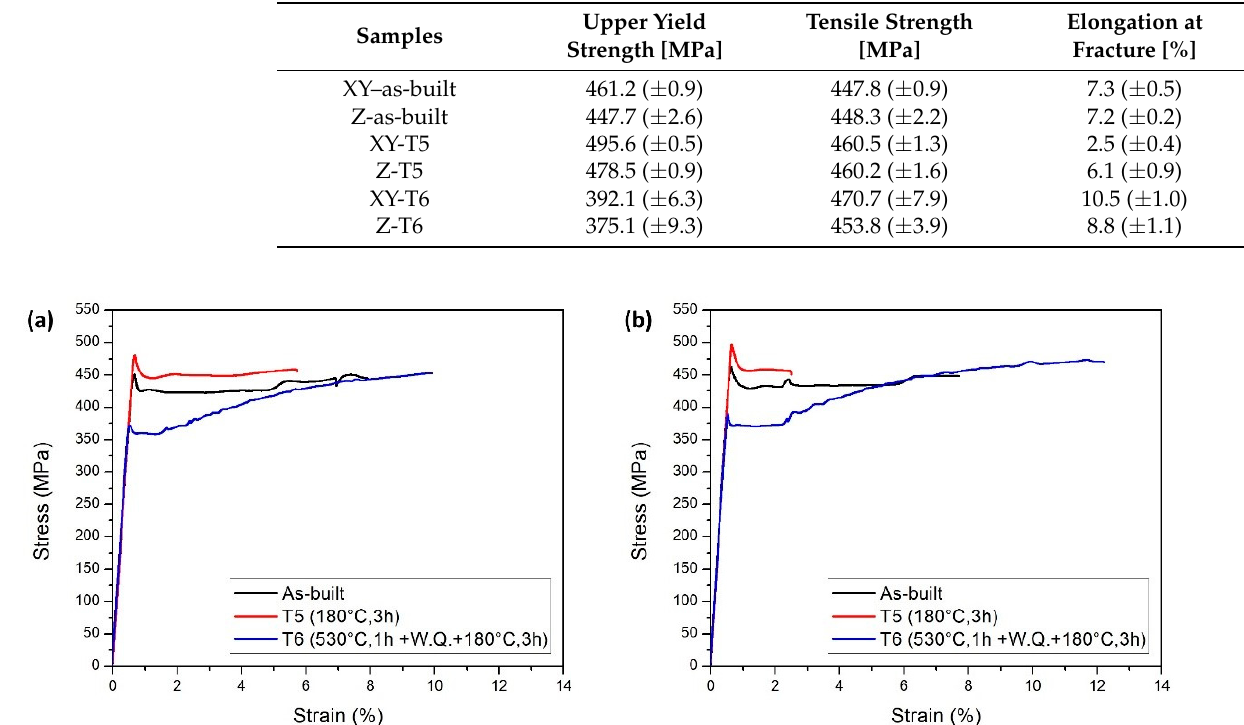
Figure 8. Room-temperature tensile curves of the as-built, T5 and T6 ( a ) Z- and ( b ) XY-specimens. Fractographic analysis was carried out on as-built tensile samples with longitudinal axis parallel to the building direction (Z-direction). Figure 9 shows the FE-SEM images of the fracture surface of a specimen. Small dimples are noticeable on the surface fracture (Figure 9a), indicating a ductile behaviour of the material. High-magnification micrograph reveals cleavage-fracture of second phase particles (Figure 9b). EDS analysis was performed on the spot labelled as A in the micrograph of Figure 9b and a high content of Ti and B was recorded, thus the particle is likely TiB 2 .